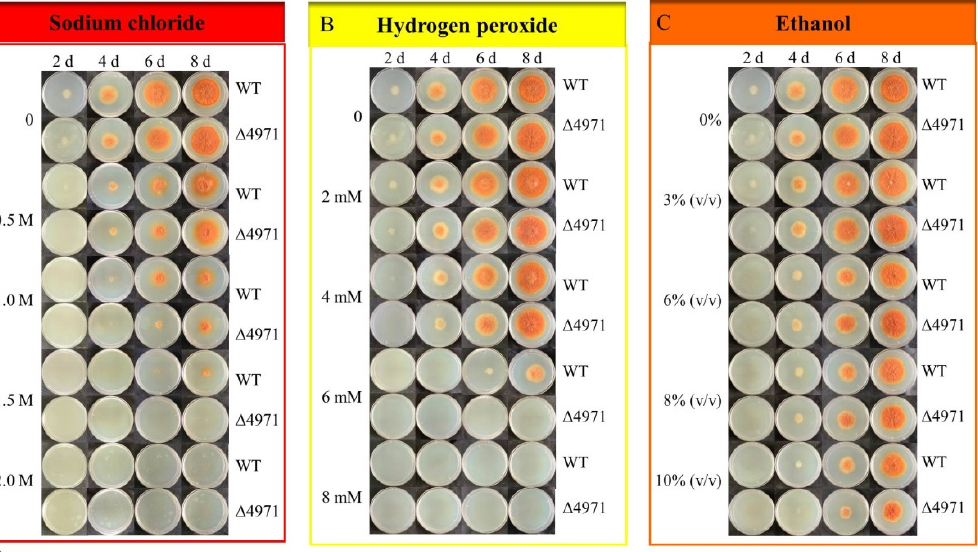
Figure 4. The sensitivities of parent strain M. purpureus LQ-6 (WT) and the mutant strain M. pur- pureus Δ 4971 cultured on PDA medium to NaCl ( A ), H 2 O 2 ( B ), ethanol ( C ). ∆ 4971 cultured on PDA medium to NaCl ( A ), H 2 O 2 ( B ), ethanol ( C